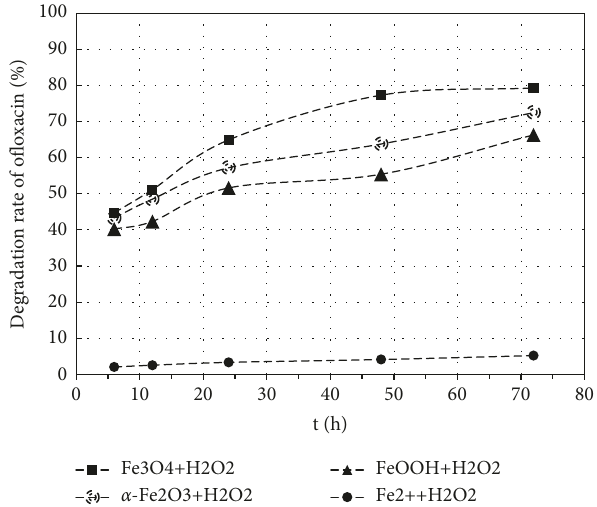
Figure 7: Different iron oxide-catalyzed Fenton-like reactions to degrade